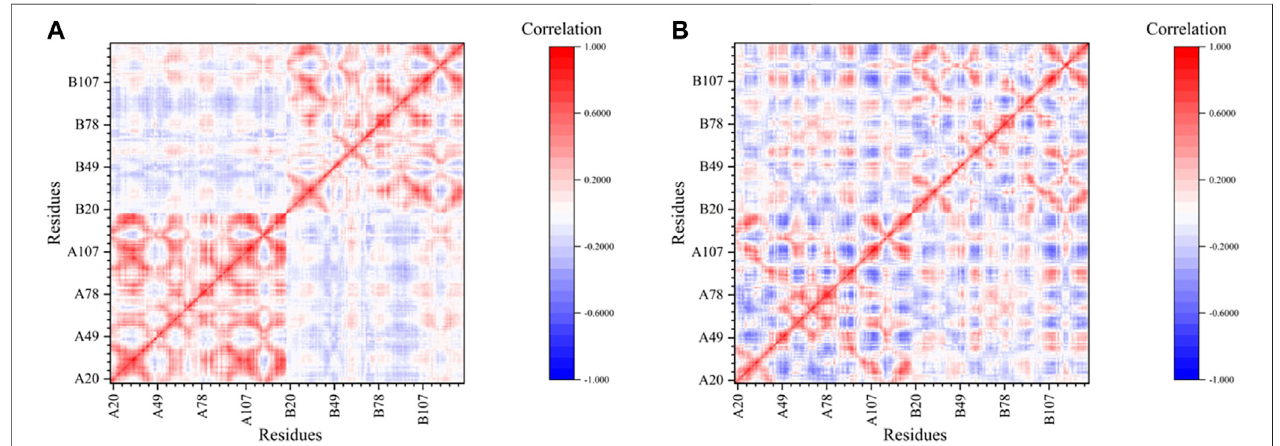
FIGURE 5 | The dynamic cross-correlation matrix (DCCM) of 5J89 system (A) and IS PP system (B) .